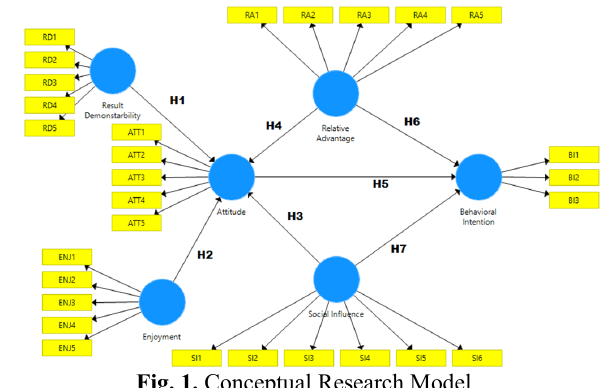
Fig. 1. Conceptual Research